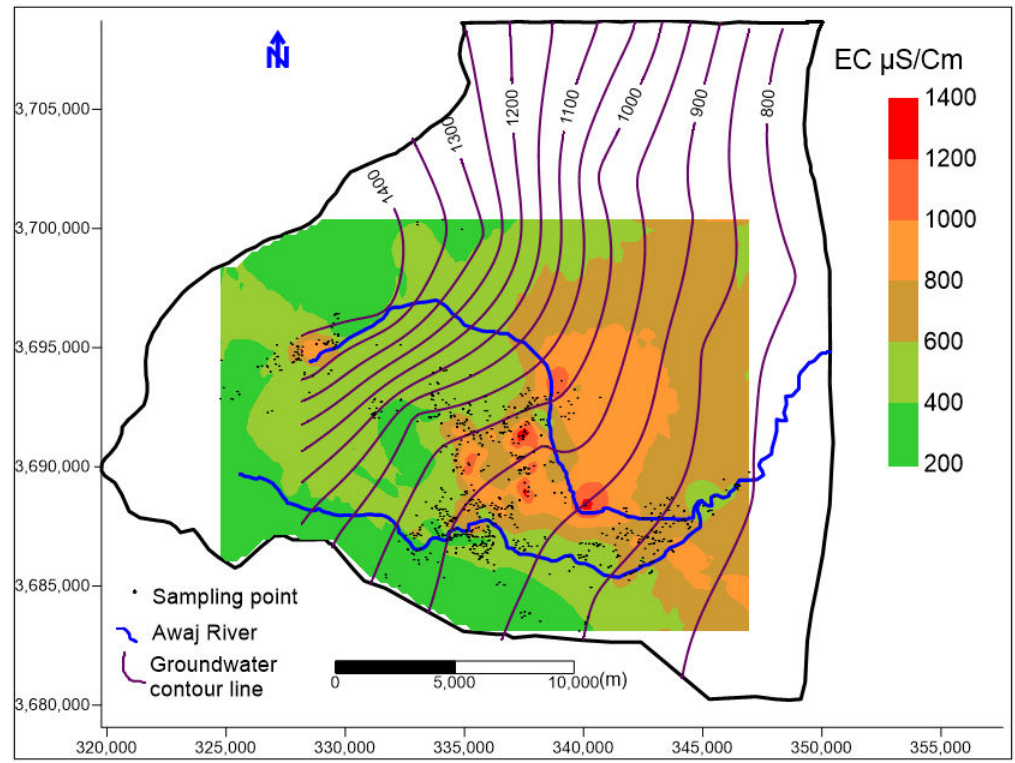
Figure 11. Spatial distribution of EC ( µ S · cm − 1 ) values in groundwater samples based on available data of field survey conducted in July and August 2006 and associated equipotential contour map based on groundwater level measured during October